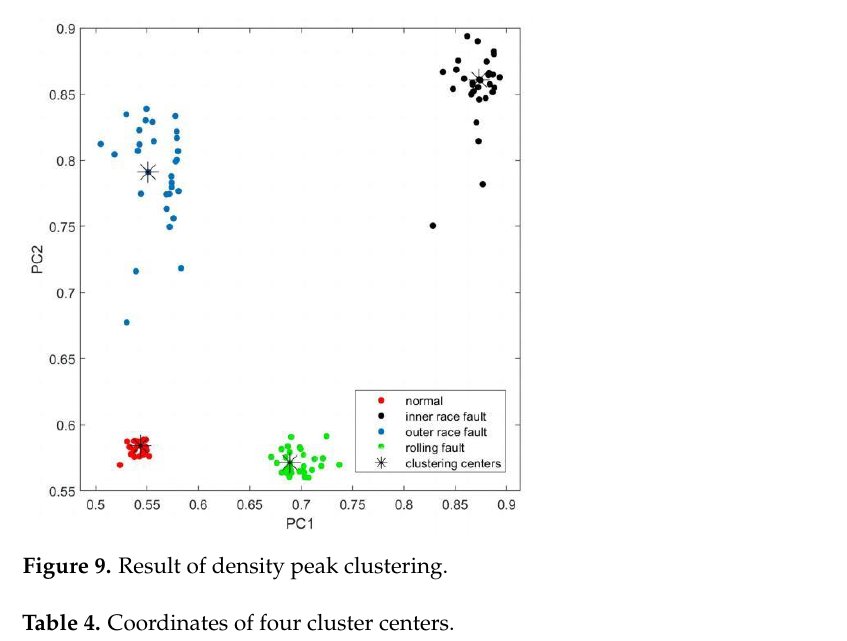
Table 3. DBI of different cutoff distances.